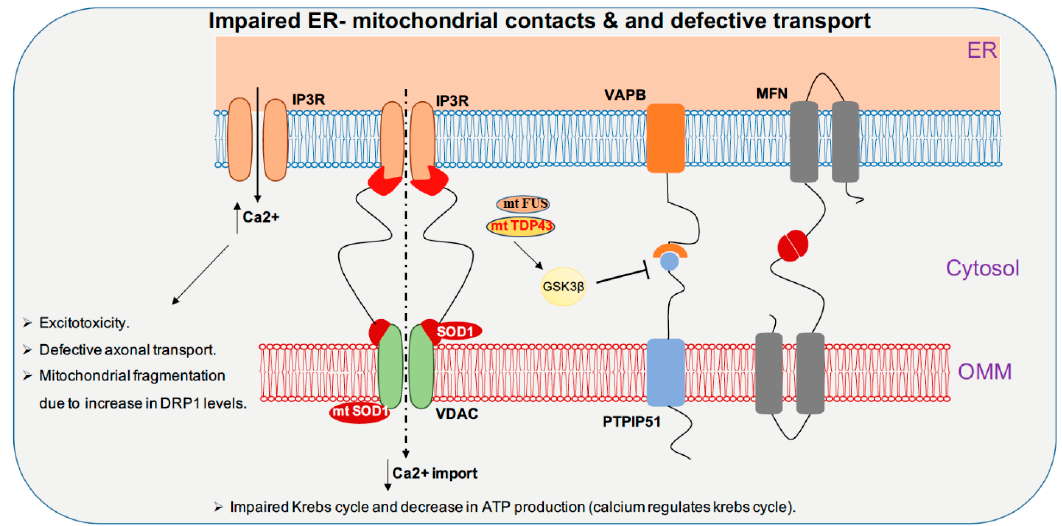
Figure 3. TDP-43, FUS, and SOD1 toxicities cause impaired Endoplasmic reticulum- mitochondrial contacts and defective mitochondrial transport. Exchange of Ca 2+ between ER and mitochondria is important for maintaining Ca 2+ homeostasis. Mutant FUS and TDP-43 pathology activate GSK3 β , which inhibits VAPB-PTPIP51 interaction leading to decrease in contact between ER-mitochondria. SOD1 mutant inhibits VDAC channels and inhibit mitochondrial import of Ca 2+ . Contact disruption leads to increase in cytoplasmic Ca 2+ levels which leads to disruption of various cellular pathways including mitochondrial transport. IP3R: Inositol triphosphate receptor, VAPB: Vesicle-associated membrane protein-associated protein B/C, MFN: Mitofusin, VDAC: Voltage-dependent anion channel, PTPIP51: Protein tyrosine phosphatase interacting protein 51, GSK3 β : Glycogen Synthase Kinase 3 Beta, ER: Endoplasmic reticulum, OMM: Outer mitochondrial membrane. Poly (GR), which results from repeat expansion in C9ORF72, favorably binds to mitochondrial